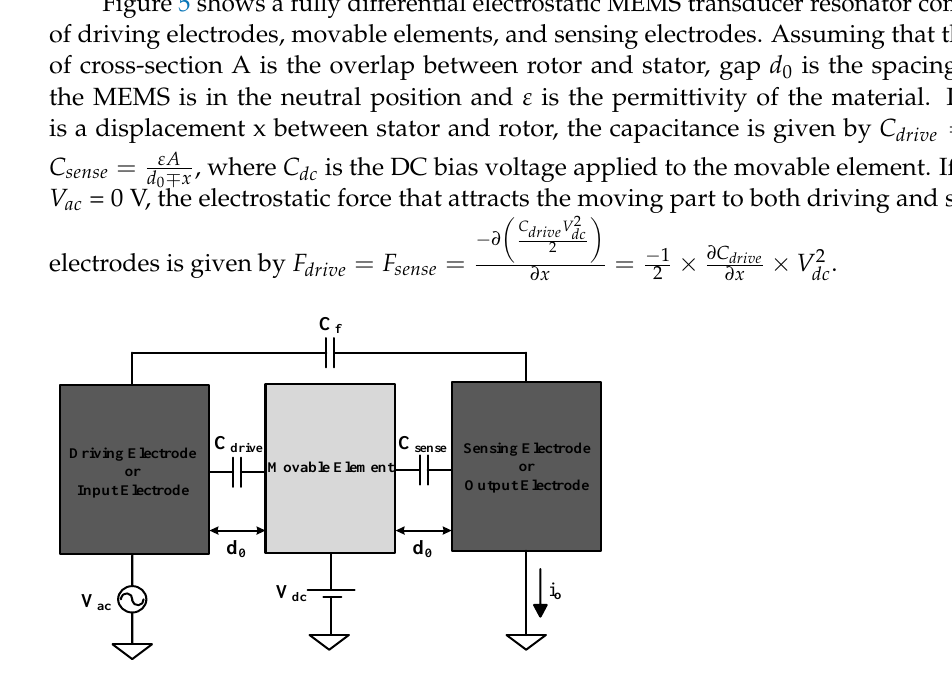
Figure 5. Model of general electrostatic MEMS transducer resonator.